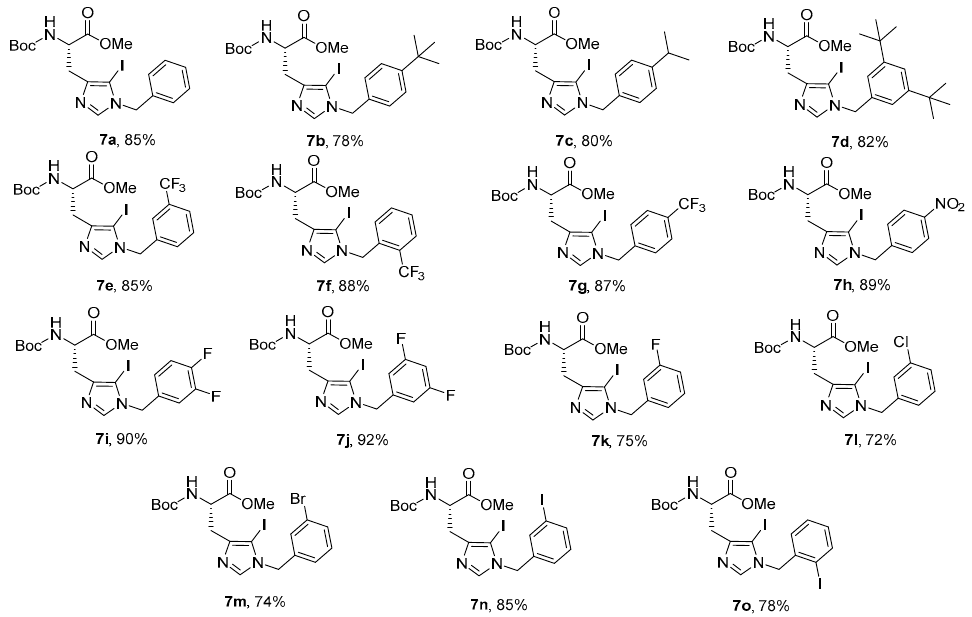
Figure 2. N- benzylated 5-iodohistidine